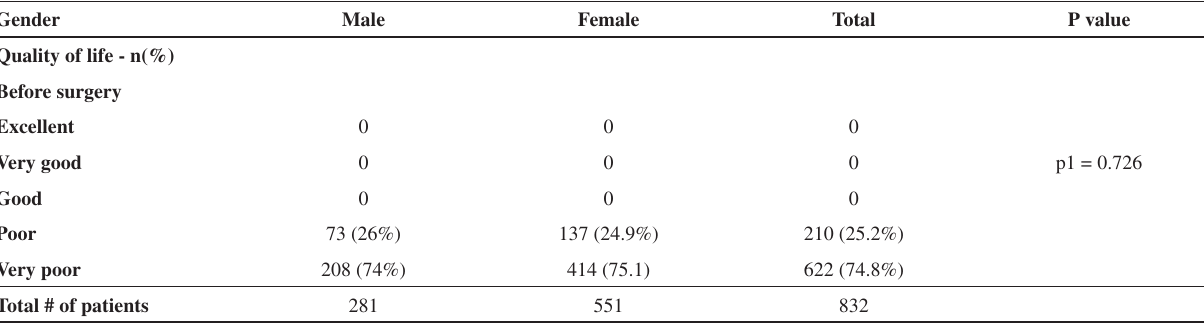
Table 2 - Quality of life before surgery.